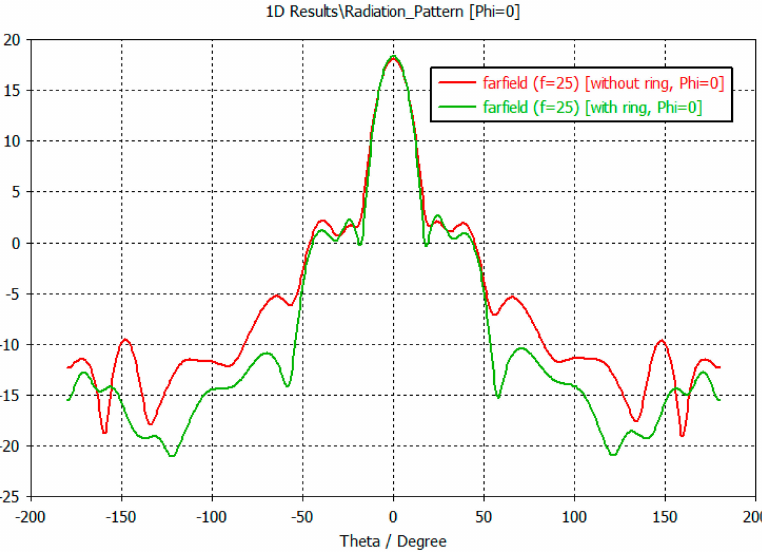
Figure 21. The radiation pattern of the microstrip antenna array with 24 elements, simulated with CST MWS, without, and with an SLL suppression ring (Phi = 0 plane).